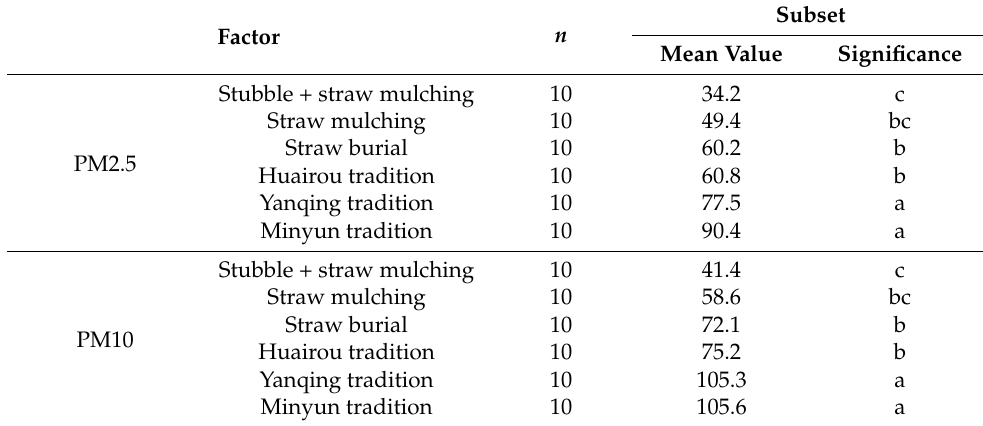
Table 5. Multiple comparison of different farming methods (Duncan